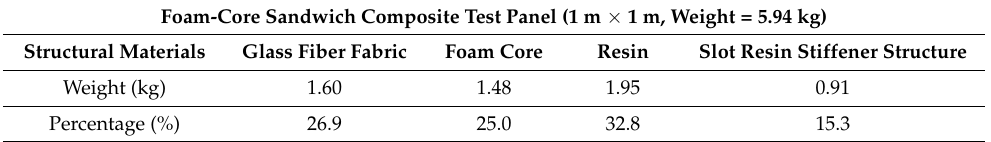
Table 1. Weight proportions in the groove resin structure of the sandwich composite.